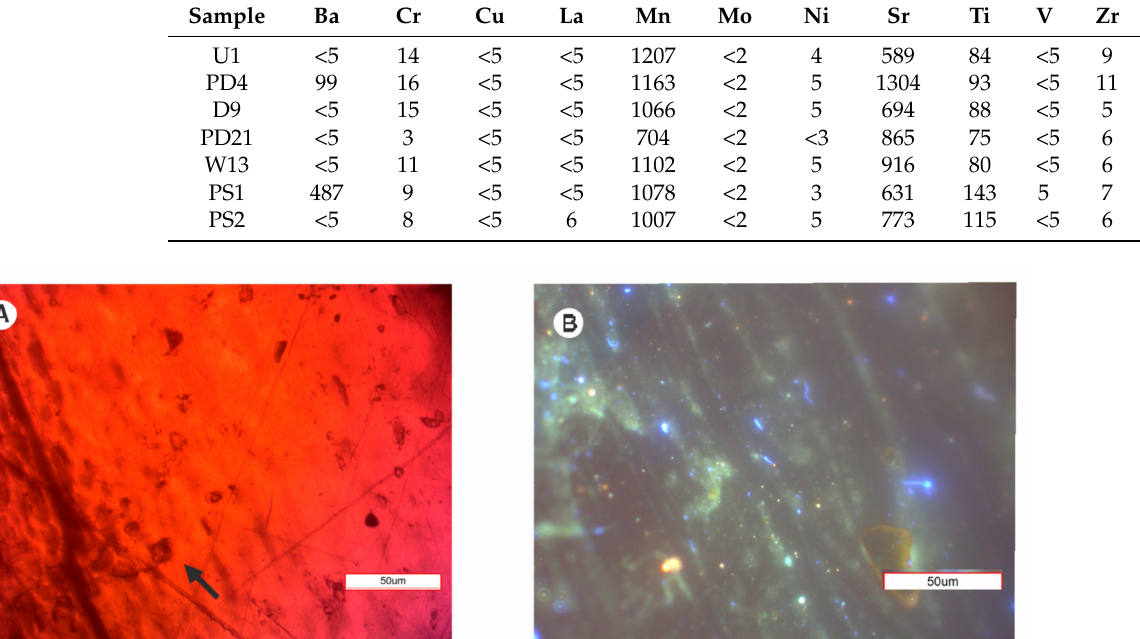
Figure 4. The photomicrograph of realgar within the tectonic m é lange in the JRC area (Rabe point). A sample due to the courtesy of T. Wieser [33]. ( A ) Polarizing microscope image. The arrow points to a bi-phase inclusion. ( B ) UV image. No characteristic